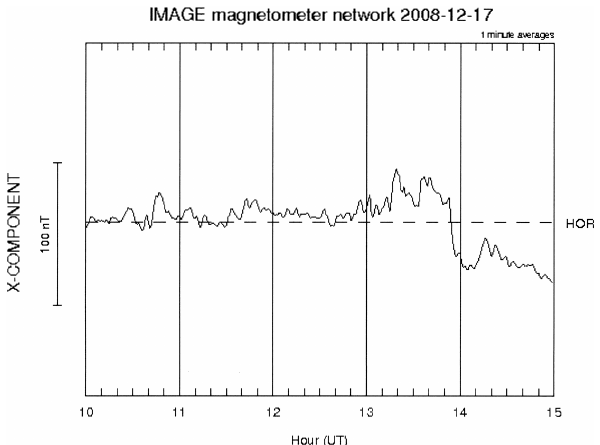
Fig. 12. X-component magnetic deflection recorded from station HOR (74 ◦ MLAT) on Svalbard. We shall focus on the negative X- deflection after 13:55UT. This magnetic deflection reflects the Hall current associated with flow channel FC 2 (see Fig.